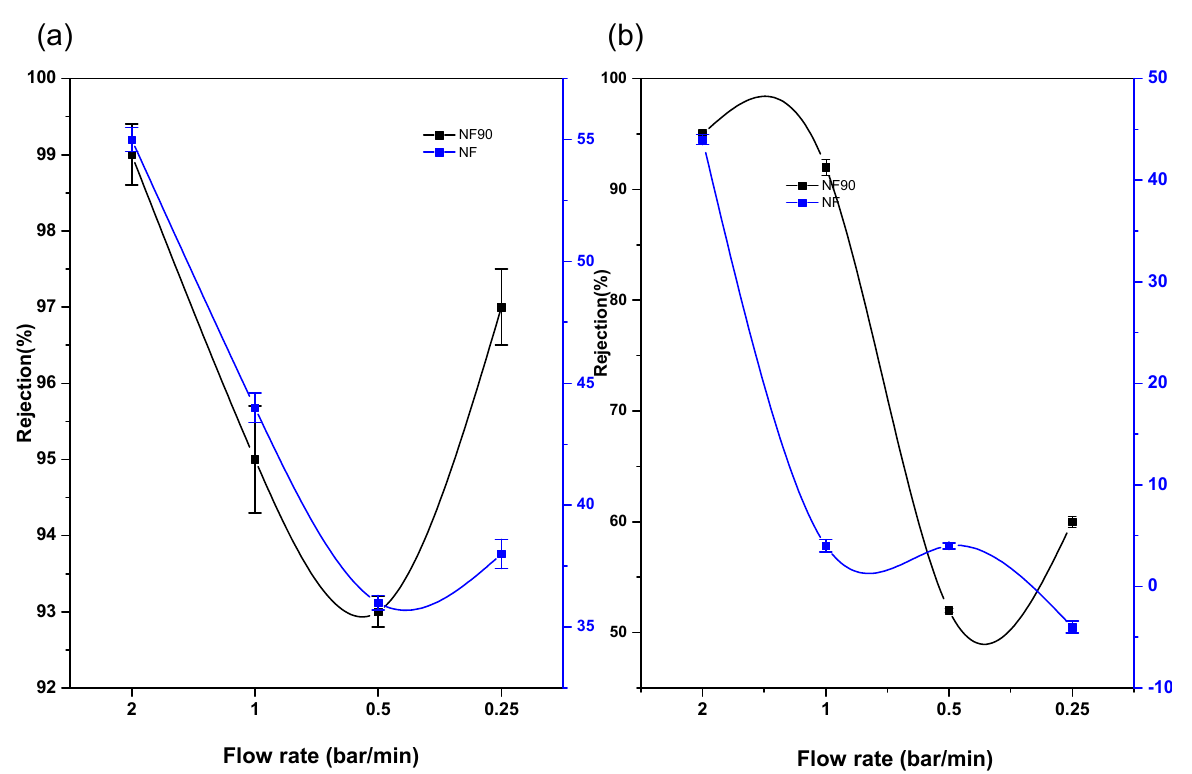
Figure 8. Membrane performance at 20 ppm and pH 2 ( a ) in the presence of chelating agent on Pd in Pd/Cu/Ni/EDTA mixture ( b ) without chelating agent on Pd in Pd/Cu/Ni/EDTA mixture.